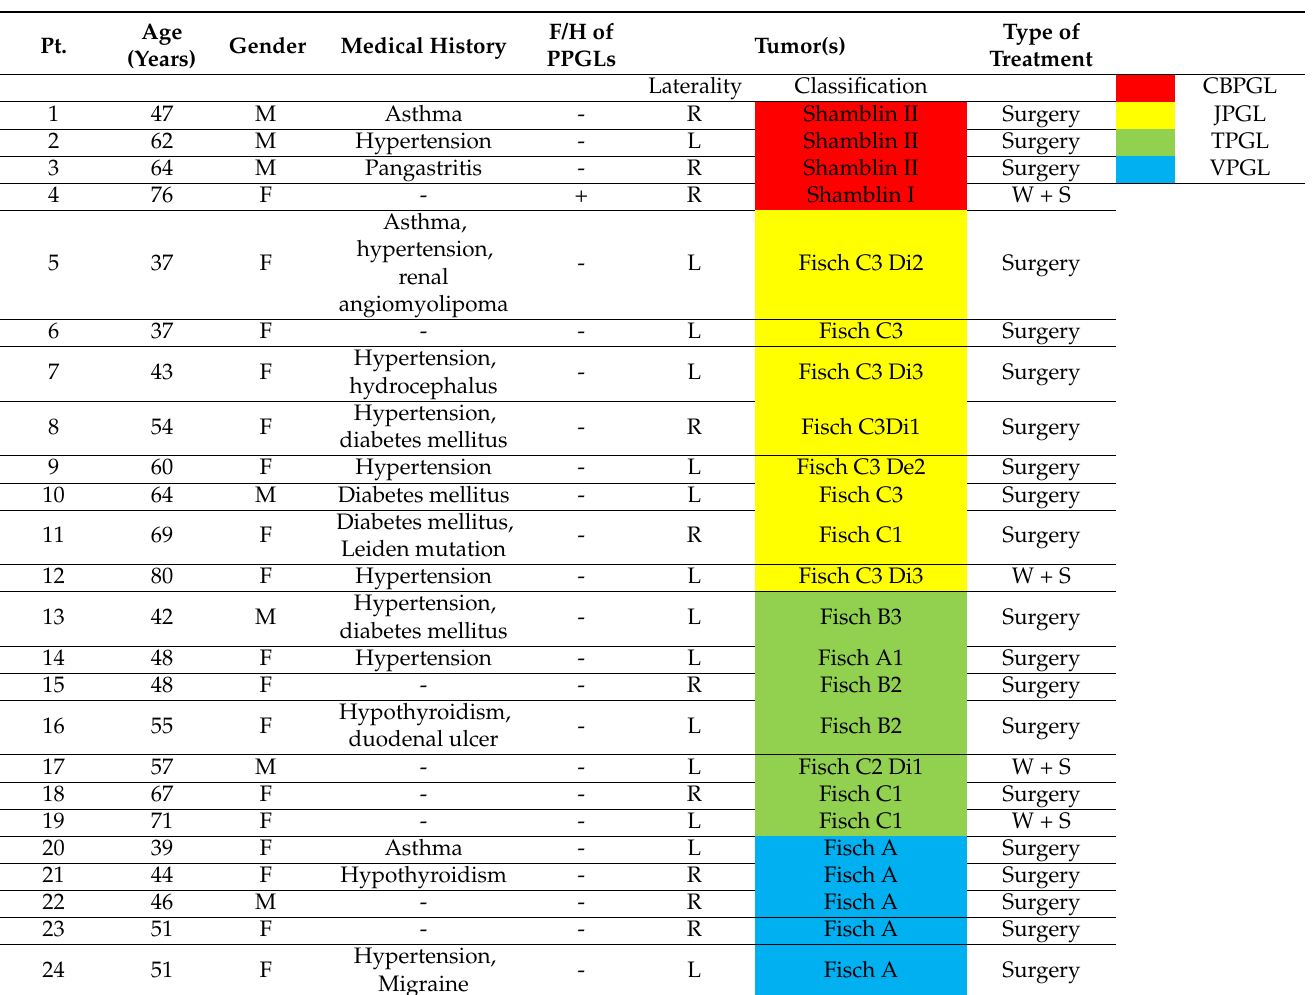
Table 1. Summary of patients with HNPGLs at our clinic between 2016 to